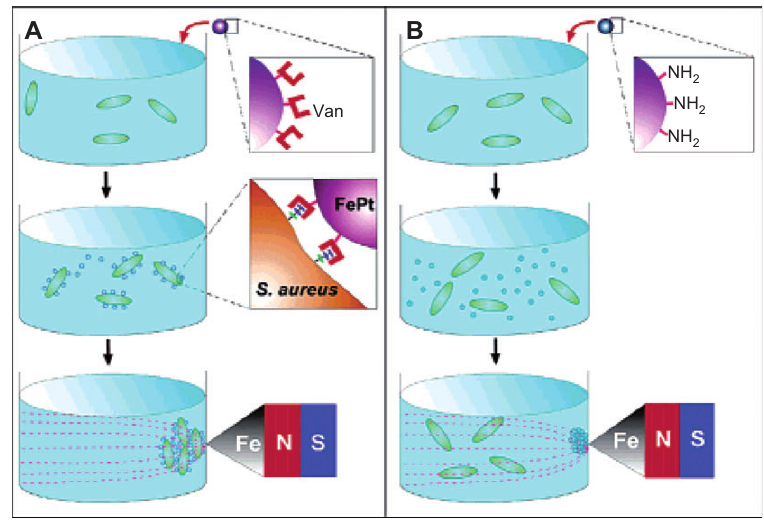
Figure 12 Illustration of the capture of bacteria by vancomycin-conjugated magnetic nanoparticles (A) via a plausible multivalent interaction and the corresponding control experiment (B) [67] . Reprinted with permission from Ref. [67] . Copyright (2003) American Chemical